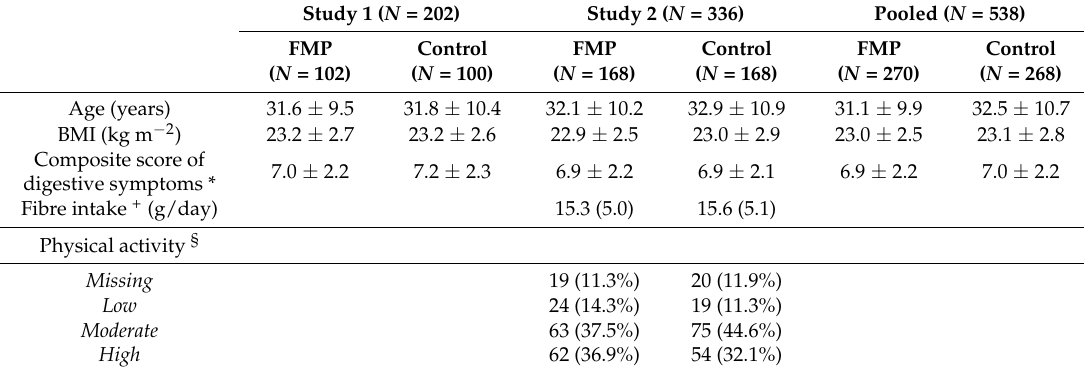
Table 1. Baseline characteristics of subjects.